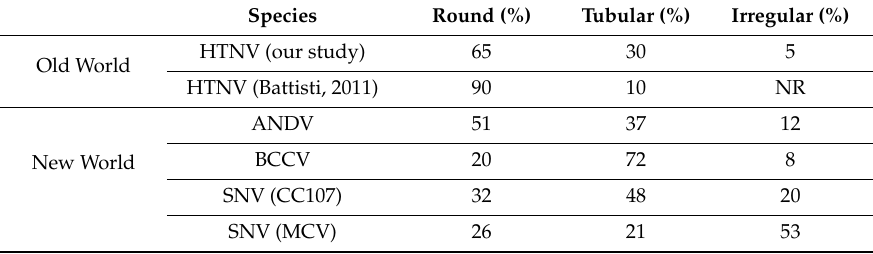
Table 1. Proportions of distinct morphologies noted in New and Old World